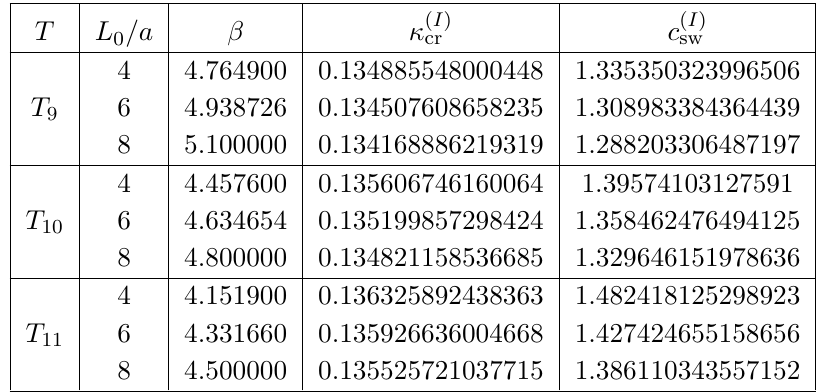
Table 7 . Parameters of the Monte Carlo simulations performed with the tree-level improved Symanzik action. The bare gauge coupling is expressed in terms of β = 6 /g 2 where L is the length of the box in direction 1 . In order to determine I 1 transfer-matrix representation of C